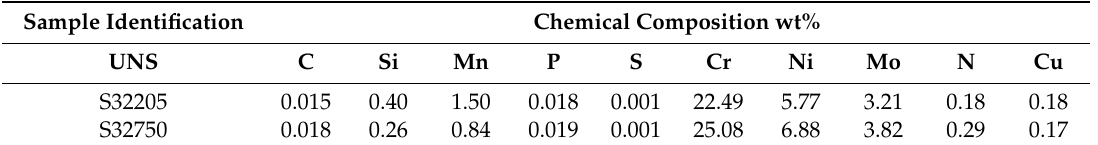
Table 1. Chemical composition of duplex (S32205) and super duplex (S32750) stainless steels (Fe